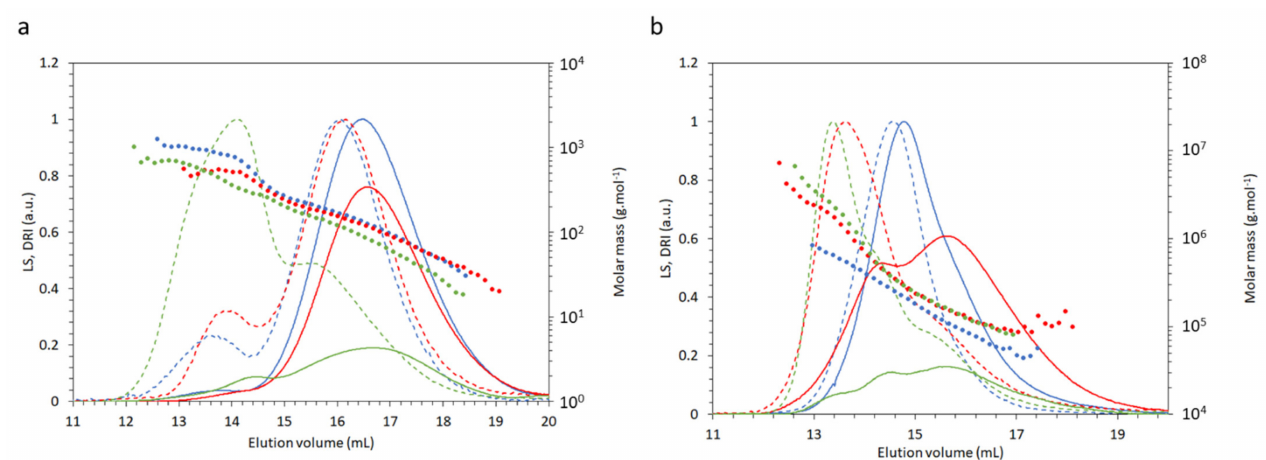
Figure 4. ( a ) Molar mass distribution of HA 38 (blue), HA 38 - g (EDC) -M2005-3.6% (red), and HA 38 - g (T3P) -M2005-8.3% (green) ( b ) Molar mass distribution of HA 140 (blue), HA 140 after reticulation with T3P ® (red), and HA 140 - g (T3P) -M2005-8.3% (green); full lines: DRI; dotted lines: LS; full circles: molar mass